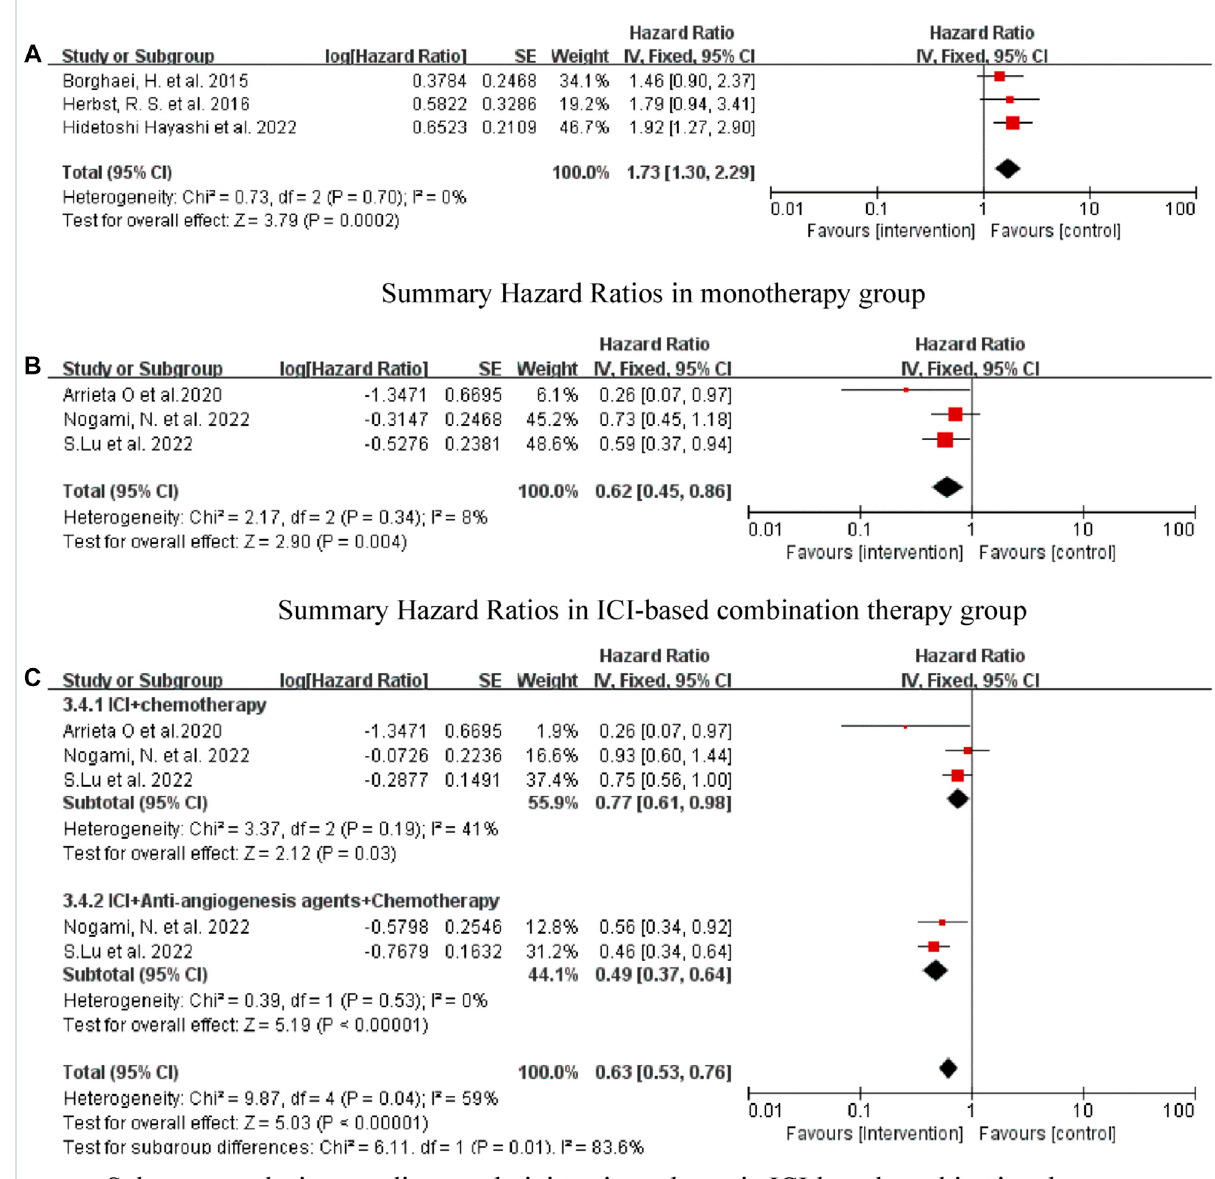
FIGURE 3 Forest Plot of HR Comparing PFS in Patients Who Received ICIs vs. Other Therapeutics. (A) Summary Hazard Ratios in monotherapy group. (B) Summary Hazard Ratios in ICI-based combination therapy group. (C) Subgroup analysis according to administration scheme in ICI-based combination therapy